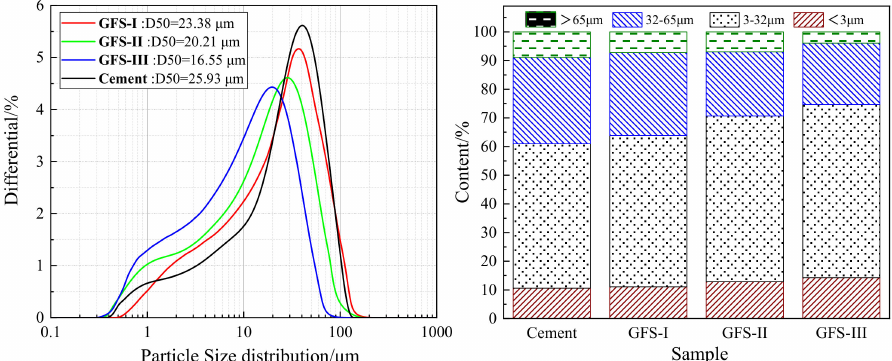
Figure 4. Particle size distribution of the GFS